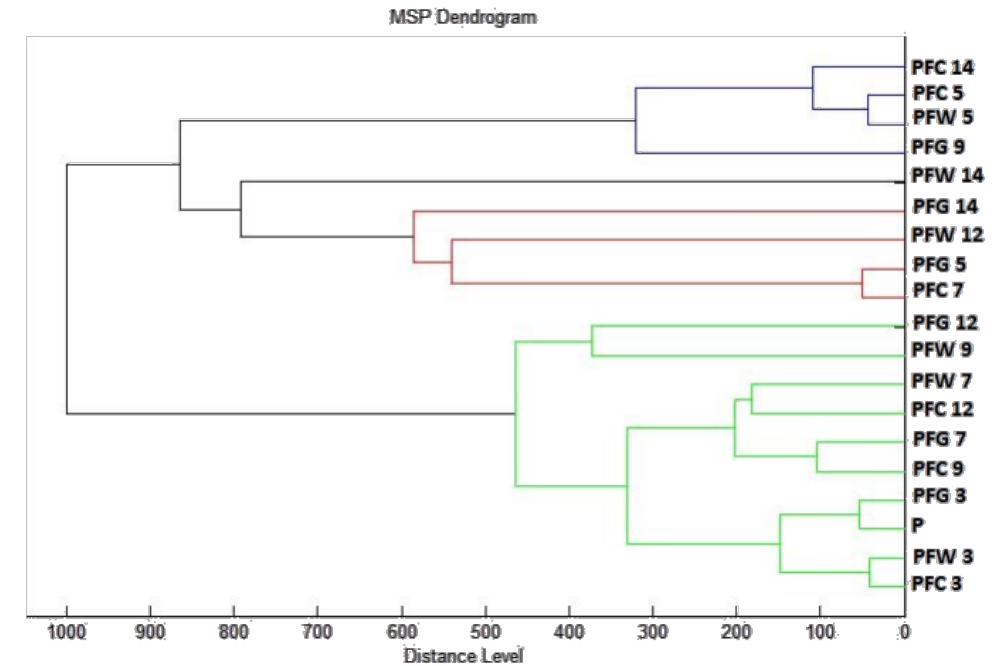
Figure 4. Dendrogram of P. fluorescens generated using MSPs of the planktonic cells and the control. PF, P. fulorescens ; C, control; G, glass; W, wood; and P, planktonic cells.